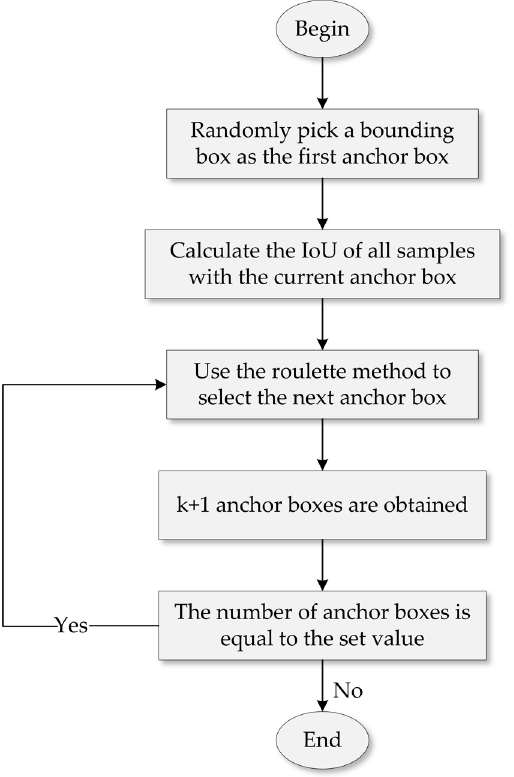
Figure 4. Improved K-means++ algorithm logic.